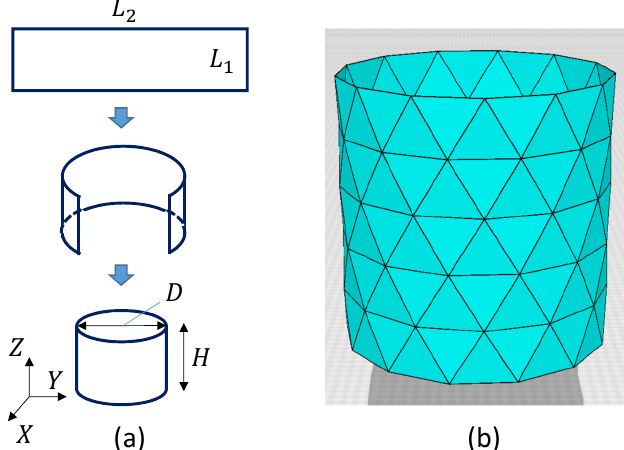
Figure 2. ( a ) A cylindrical surface is made of a rectangular surface of size L 1 × L 2 , where L 1 and L 2 are integers, and ( b ) a triangulated cylinder of size N = 78, where the total number of boundary vertices is N bnd = 2 ( L 2 − 1 )= 26. Small numbers L 1 (= 6 ) and L 2 (= 14 ) are assumed here to visualize triangles clearly. The height H 0 and the diameter D are given by Equation (1) with the edge length a